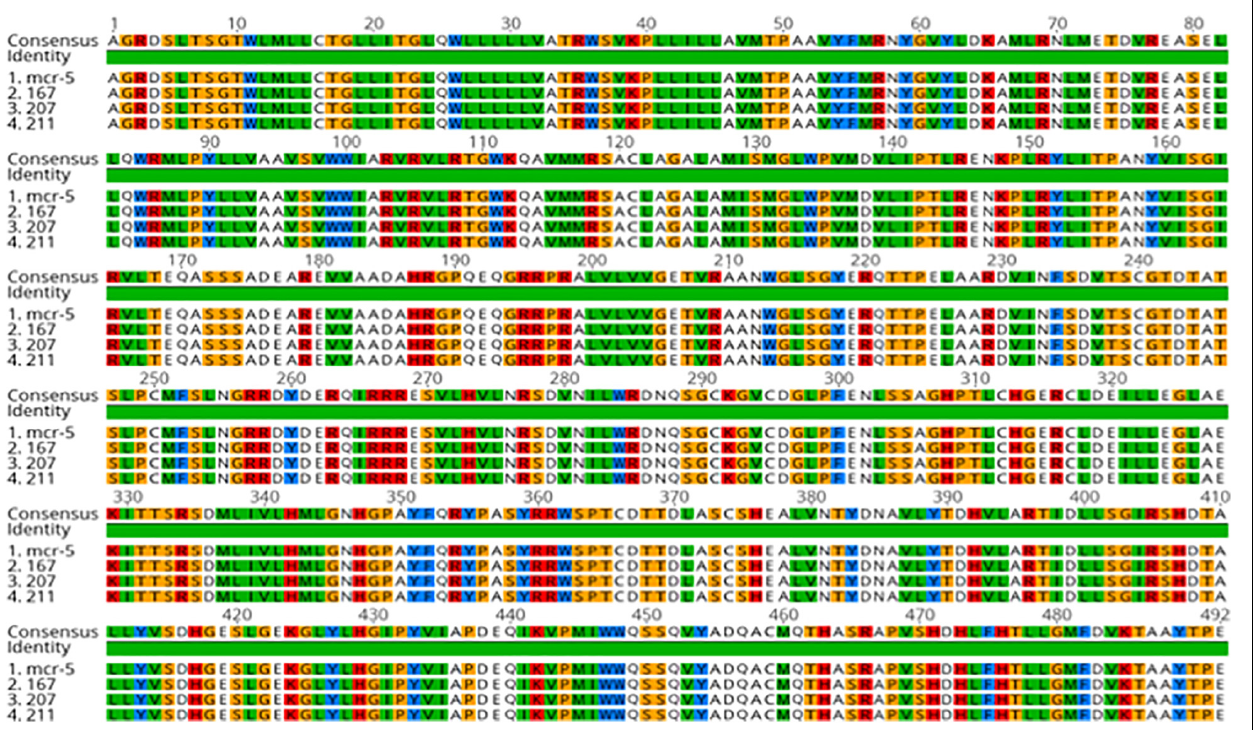
FIGURE 4 | Protein Alignment of mcr-5 positive strains examined in this